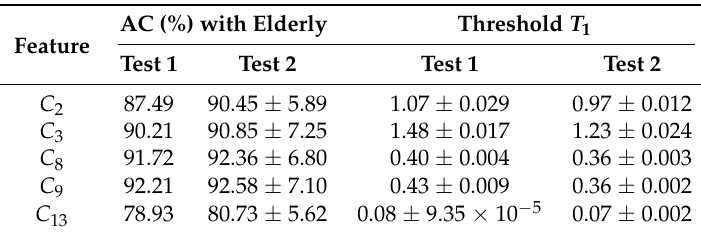
Table 6. Variation in accuracy and threshold T 1 after training exclusively with the young but validating with elderly people (test 1), and then training and validating with elderly people (test 2).